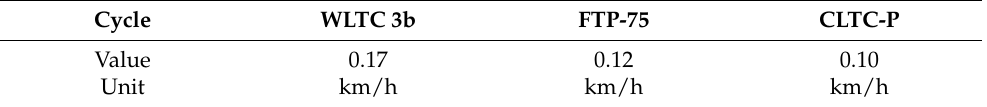
Table 8. Standard deviation values of the momentary difference between vehicle speed and cycle speed for three driving